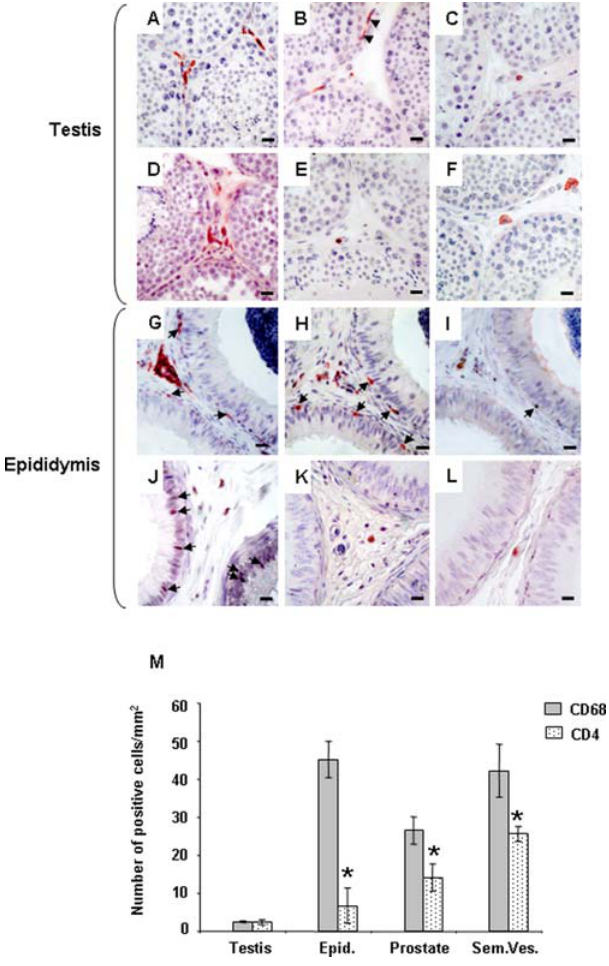
Figure 1. Localization and quantification of SIV/HIV target cells in the male genital tract. Testis (A–F) and epididymis (G–L) immunolocalization of HLA-DR (A, G), CD68 (B, H), CD3 (C, I), CD4 (D, J), CCR5 (E, K) and CXCR4 (F, L) positive cells in uninfected macaques. Arrows show immunopositive cells in contact with the epithelium of the epididymis. Note the presence of testicular macrophages within the peritubular wall bordering the seminiferous tubules of the testis (Figure 1H, arrow heads).Scale bars=20 m m. (M): Quantification of HIV potential target cells (CD68 + and CD4 + stained positive cells) in the male reproductive organs of uninfected macaques. Stars indicate statistical difference between the number of CD68 + cells and CD4 + cells within an organ (Wilcoxon signed rank test, p , 0.05;). The number of CD68 + cells was significantly lower in the testis when compared with the other MGT organs (Wilcoxon signed rank test, p , 0.05, not shown on the graph). The number of CD4 + cells in the testis was significantly lower than in the prostate and seminal vesicles (Wilcoxon signed rank test, p , 0.05, not shown on the graph).